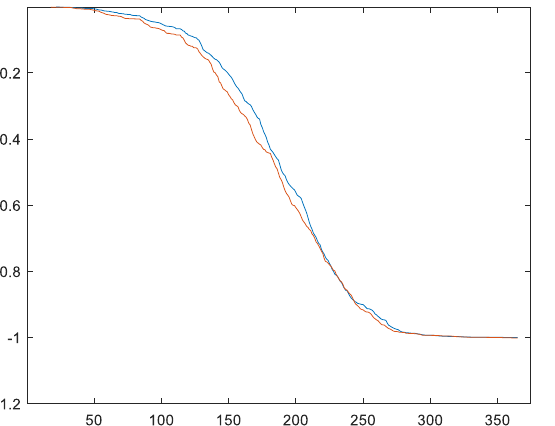
Figure 11. Onshore (red) and offshore (blue) cumulative effect, normalized with corresponding yearly final value.